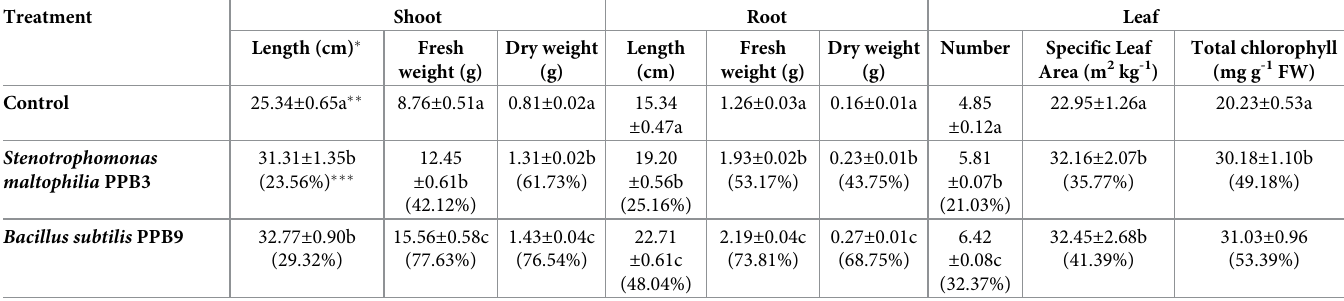
Table 3. Effect of Stenotrophomonas maltophilia PPB3 and Bacillus subtilis PPB9 treatment on the growth of tomato plants in pots. Treatment